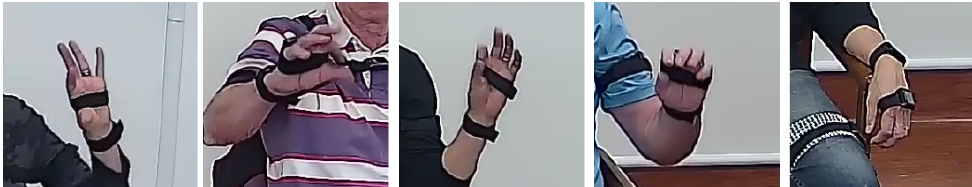
Figure 7. Examples of PD-APDM-Hand, which is collected from real Parkinson’s Disease patients when taking the UPDRS